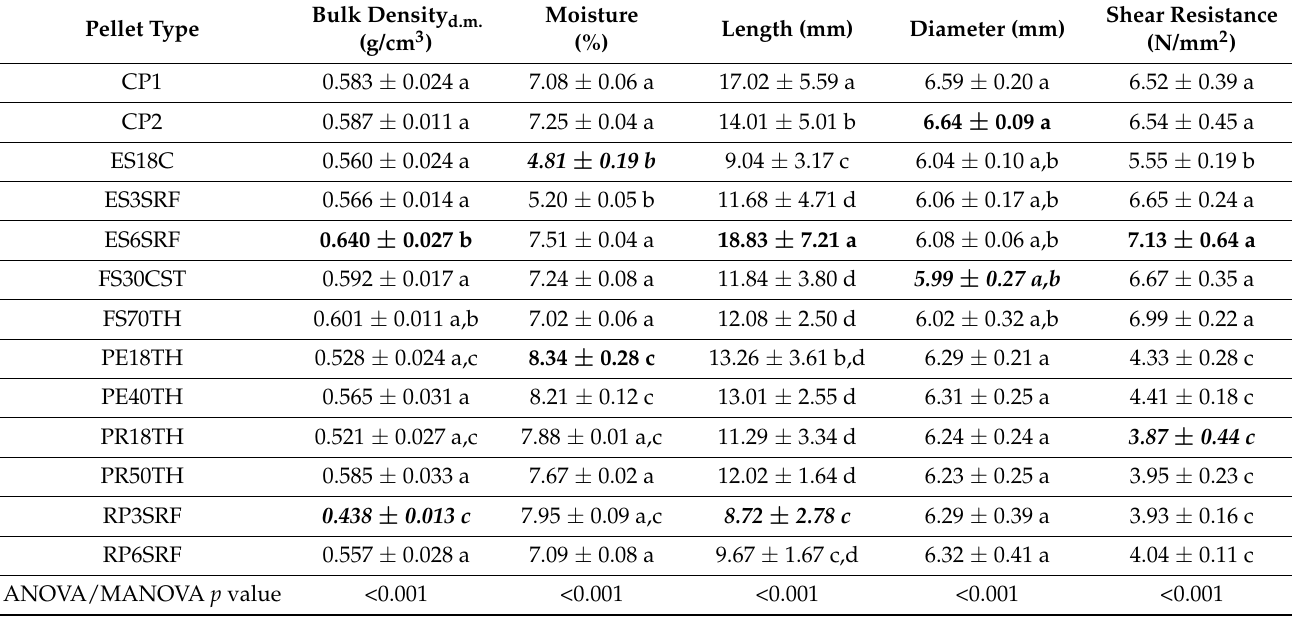
Table 3. Average ± standard deviation for some physical parameters of various pellet types. It can be seen that most parameters show statistically significant differences. The highest values are highlighted in Bold, while the lowest values are in Bold-Italic. Different letters show statistically different groups (at a significance level of 5%) following Tukey’s test for physical parameters. (d.m.: dry